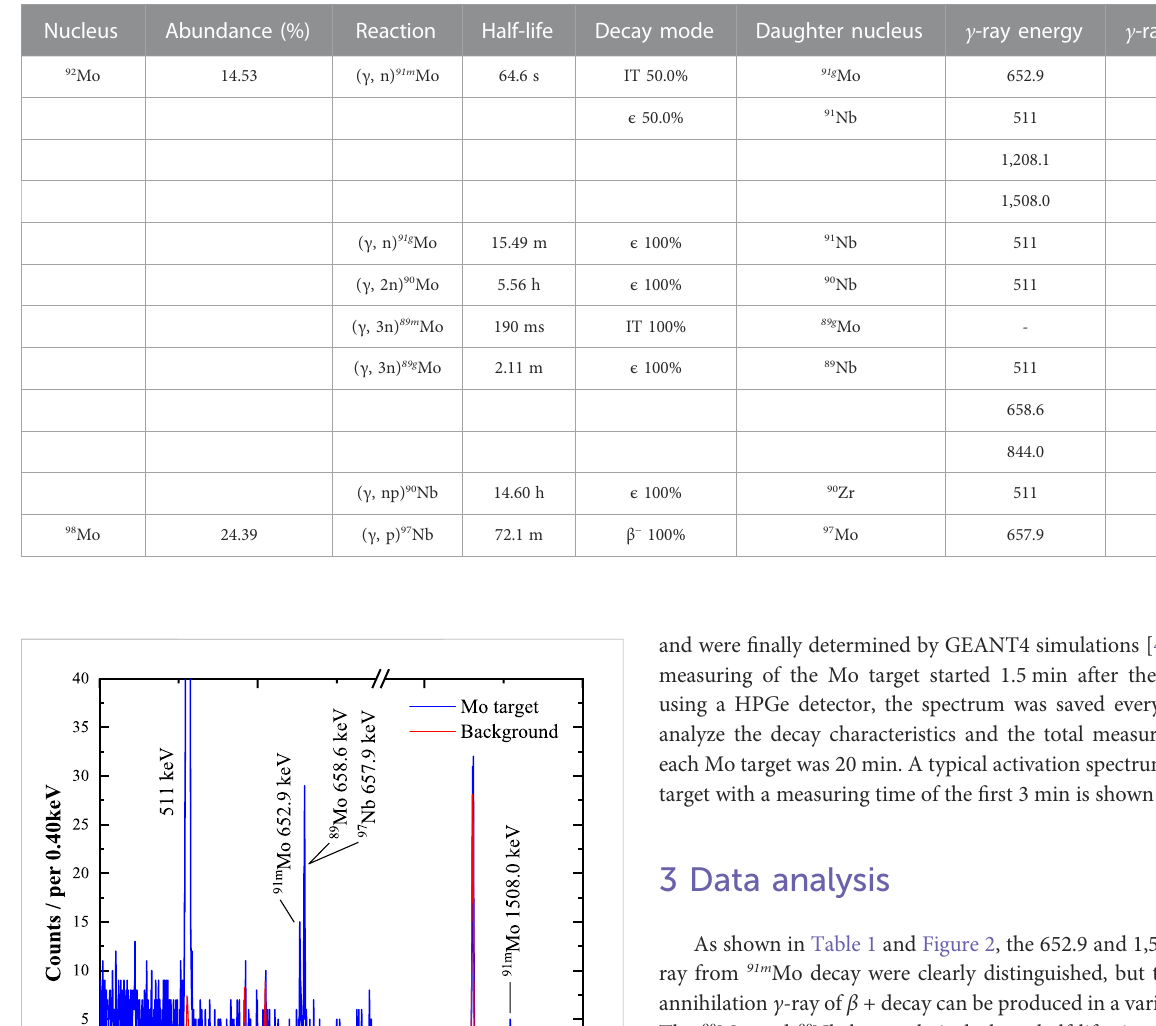
TABLE 1 Relative nuclear spectroscopic data of the radioactive nuclei from the Mo photonuclear reactions. Nucleus